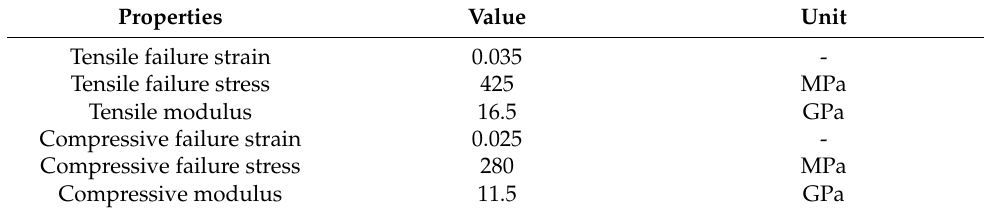
Figure 1. Sectional analysis of sleeper Concept-1 (ignoring the contribution of low strength infill material thus a linear strain and stress distribution for exterior Fiber Reinforced Polymer (FRP)). Table 2. Nominal Properties of GFRP Laminates.